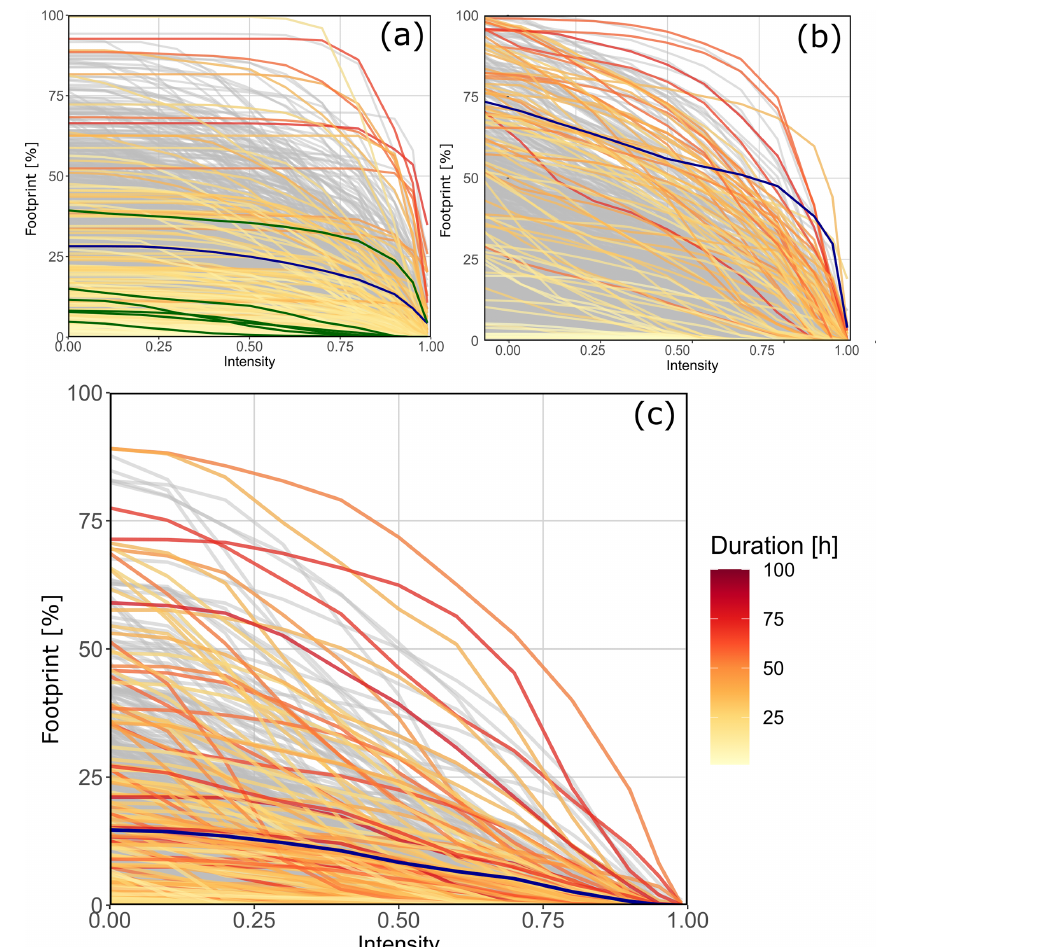
Figure 13. Spatial–quantile plot for 18086 precipitation, 6190 wind, and 4555 compound clusters for January 1979 to September 2019 from the ERA5 Hazard Clusters Database 1979–2019 (Supplement 3). The footprint (in percent of the total area) is given as a function of the intensity of single and compound hazard events. The intensity (from 0.00 to 1.00) is expressed by (a) the cumulative probability (Eq. 3) of the precipitation accumulation at each grid cell during all precipitation events, (b) the cumulative probability (Eq. 3) of the wind “accumulation” at each grid cell during all wind events, and (c) the minimum cumulative probability (Eq. 4) of the compound hazard (wind + precipitation) events. Coloured curves represent clusters associated with events from our Great Britain Significant Weather Events Catalogue 1979–2019 (Supplement 4); colours represent the duration of the events. Grey lines represent all other events in each database (Supplement 3). The blue curve in each part represents the individual hazard event clusters for precipitation, wind, and compound displayed in Fig. 12. In panel (a) , the green curves represent the clusters matched with unique event 62 from our Great Britain Weather Events